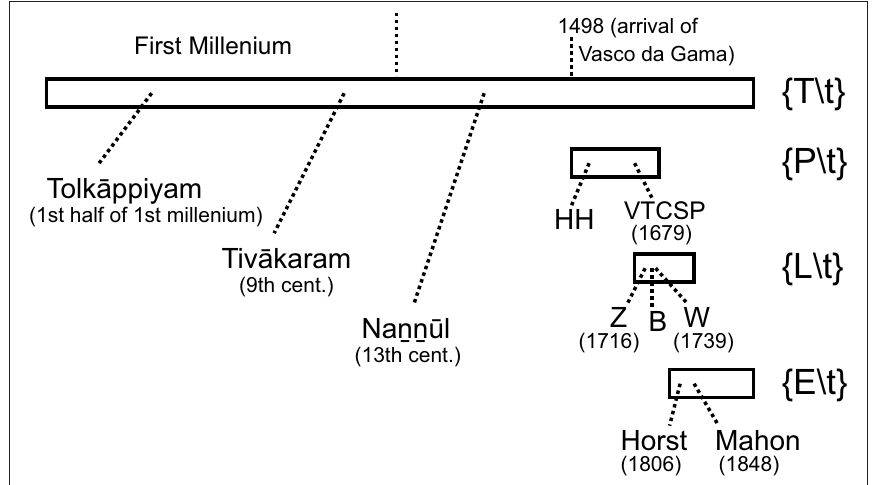
Figure 5: Brief chronology of the early stages in the description of Tamil HH = Henrique Henriques; Z = Ziegenbalg; B = Beschi; W = Walther; P = Portuguese; L = Latin; E = English; t = Tamil as object-language; {T\t} stands for a description of Tamil (=t) written in Tamil